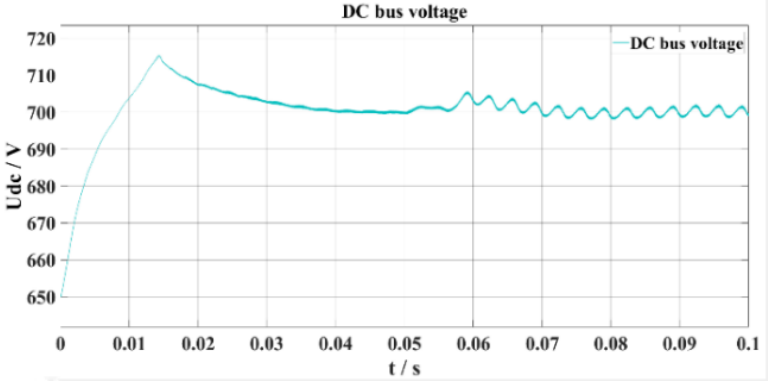
Figure 11. DC bus voltage simulation diagram.